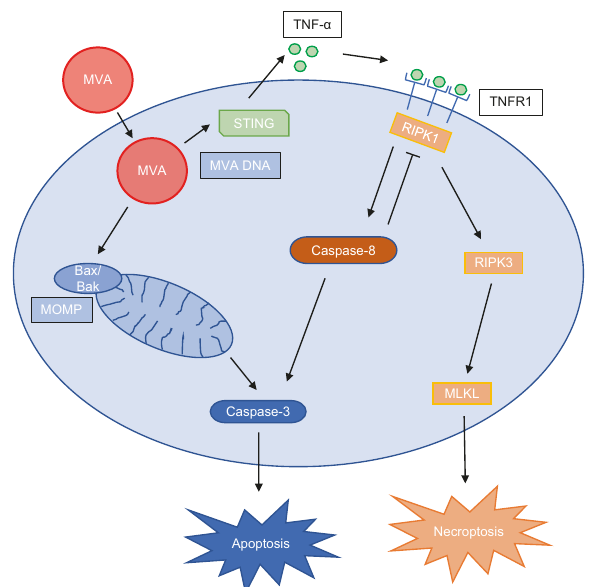
Fig. 8 Schematic overview of cell death-signaling induced by MVA-infection in murine macrophages. MVA infection in macro- phages activates various signaling pathways which include both innate immune responses and cell death signaling. Recognition of MVA in the cell leads to STING-dependent TNF secretion. Cell death signaling pathways activated by MVA comprise Bax/Bak-dependent mitochon- drial apoptosis and extrinsic apoptosis via STING-mediated autocrine/ paracrine TNF signaling. In the absence of caspase activity, cell death shifts to RIPK3/MLKL-dependent necroptosis. Inhibition of individual pathways leads to compensatory death through the other pathways. (MOMP, mitochondrial outer membrane